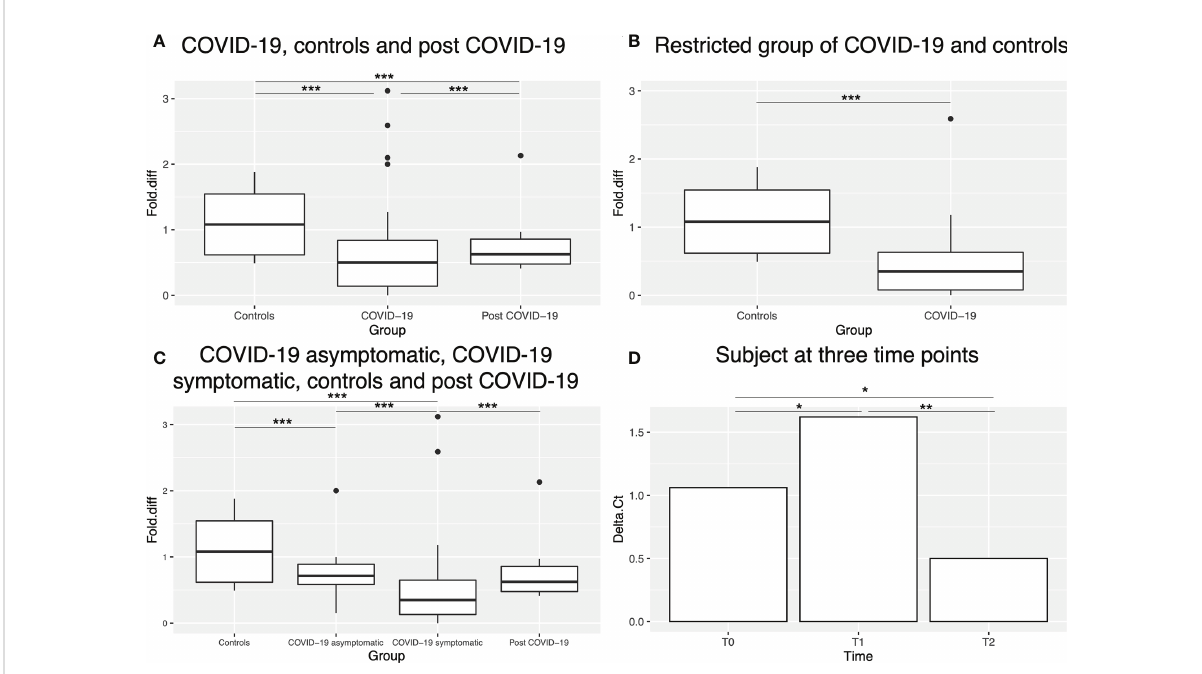
FIGURE 5 HLA-C expression in different sample groups. (A) Box plot showing HLA-C expression levels (as fold difference) in controls, COVID-19 and post- COVID-19 patients. Outliers are shown as dots outside the boxes. (B) Box plot showing HLA-C expression levels (as fold difference) in controls and the restricted group of COVID-19 patients (without potential confounding factors, see Materials and Methods). (C) Box plot showing HLA-C expression levels (as fold difference) in controls, asymptomatic, symptomatic and post-COVID-19 patients. (D) Bar plot showing HLA-C expression levels (as Delta Ct) in one subject at three time points. * indicates p-value <0.05, ** indicates p-value <0.01 and *** indicates p-value